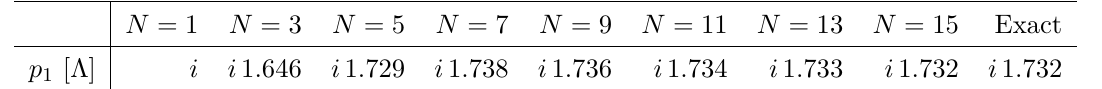
Table 4 . Deepest binding momentum in units of Λ = mαγ E of the S -wave PWA T C ( p 2 ) for Coulomb scattering with v ( δ ) calculated at order δ N , for N = 1 , 3, . . . ,15. The pole positions are compared with the exact result i/γ E given in the last column. The (non-monotonic) convergence in the results as N increases is explicitly